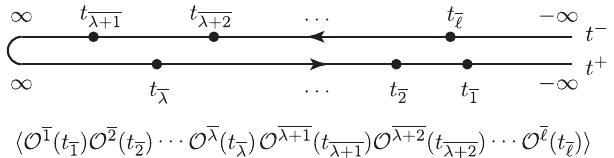
FIG. 4. KF time ordering. The l -tuples of times t ¼ ð t 1 ; … ; t l Þ and contour indices c ¼ ð c 1 ; … ; c l Þ specify an l -tuple on the forward or backward branch, ð t c 1 1 ; … ; t c l l Þ , with t ∓ i respectively. Consider such an l -tuple, with λ contour indices equal to þ , the others − . Then, only that permutation p in ≠ 0 , denoted Eq. (56) yields a nonzero contribution, K c p ð t p Þ K ½ λ ; l − λ (cid:3) ð t , for which the permuted l -tuple ð t c ¯1 ¯1 ; … ; t c ¯ l ¯ Þ has the p Þ l ; t − ; … ; t − ¯ form ð t þ ¯1 ; … ; t þ ¯ Þ , with t ¯1 < t ¯2 < (cid:2) (cid:2) (cid:2) < t ¯ λ and l λ λ þ 1 t > t > (cid:2) (cid:2) (cid:2) > t ¯ l . In the corresponding operator product λ þ 1 λ þ 2 S ½ O t , all (forward-branch) t − times appear to the right of all p (cid:3)ð p Þ (backward-branch) t þ times, with larger t − to the left of smaller t − , and smaller t þ to the left of larger t þ . In other words, the right- to-left order of operators in the product matches the order in which their times appear on the